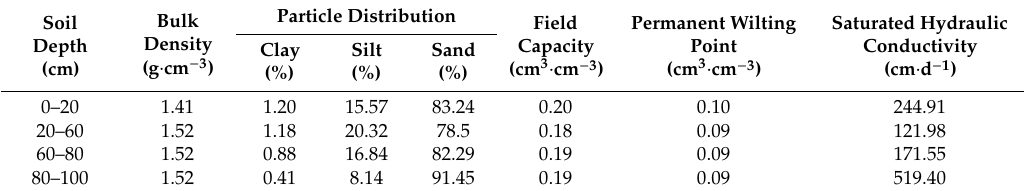
Table 1. Soil properties in the top 0–100 cm layer.